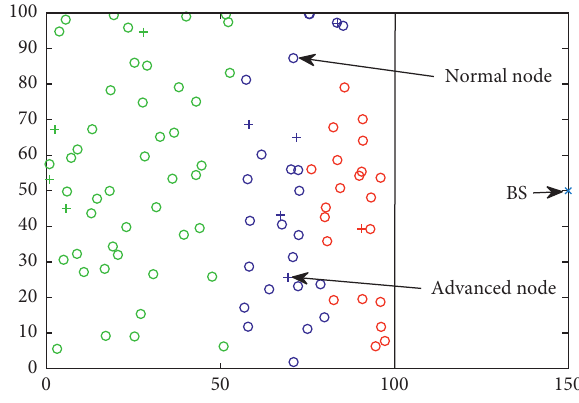
Figure 4: Distribution diagram of initial